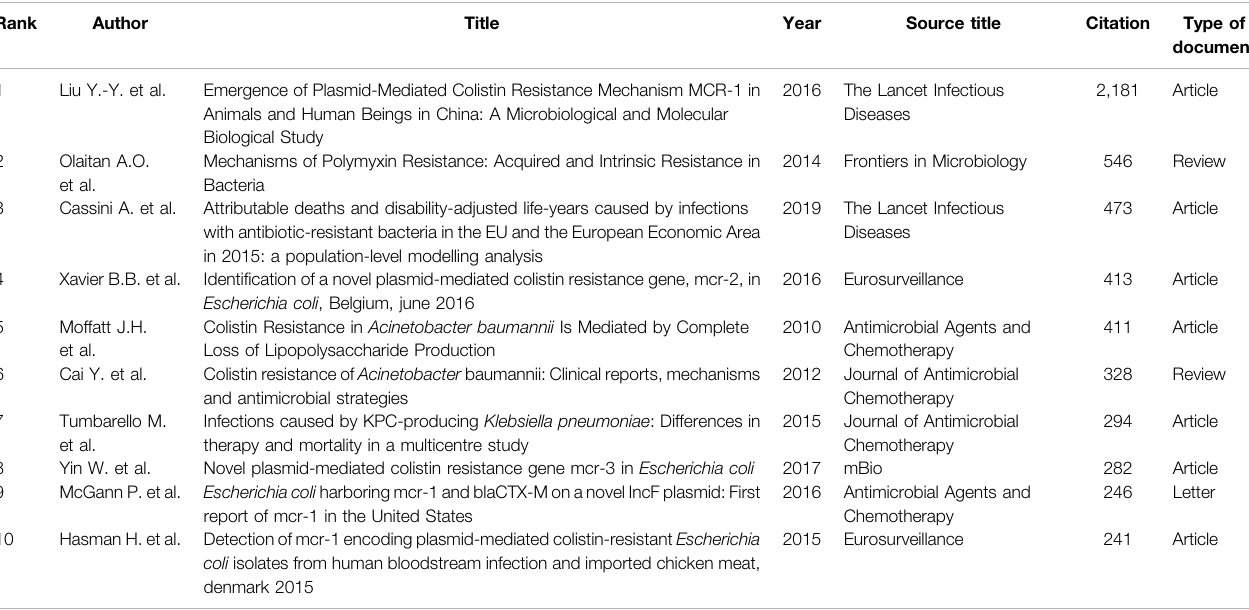
TABLE 1 | Top ten cited documents on polymyxin resistance (2010 –